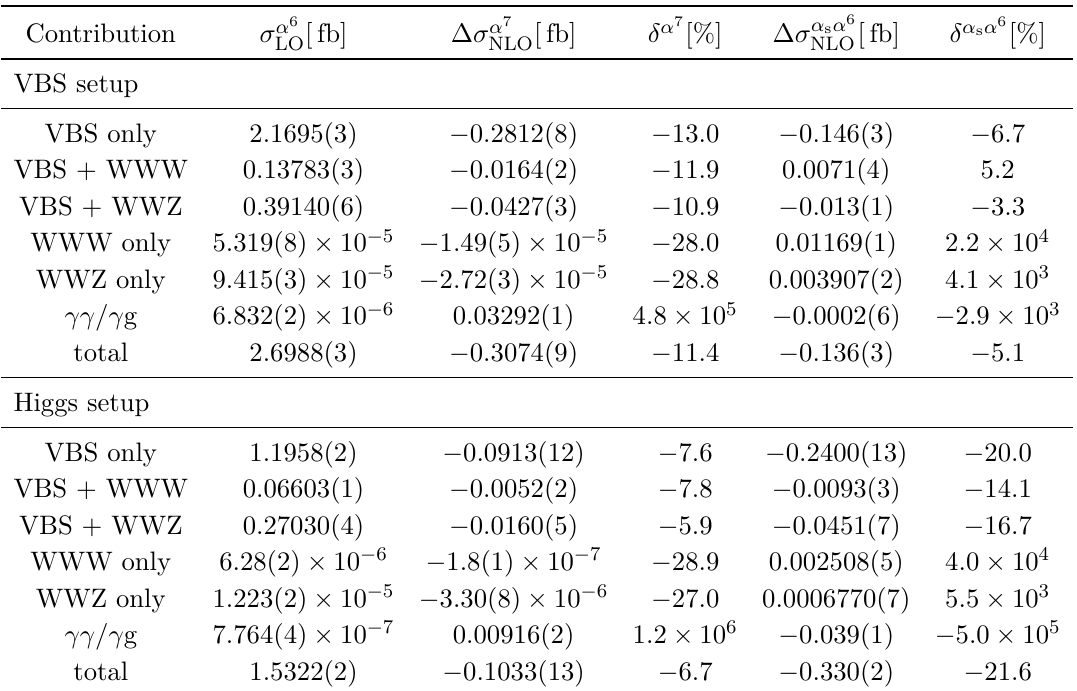
(cid:0) (cid:1) (cid:0) (cid:1) α 7 and α s α 6 in relation to their LO counterparts of O O /σ α 6 LO NLO